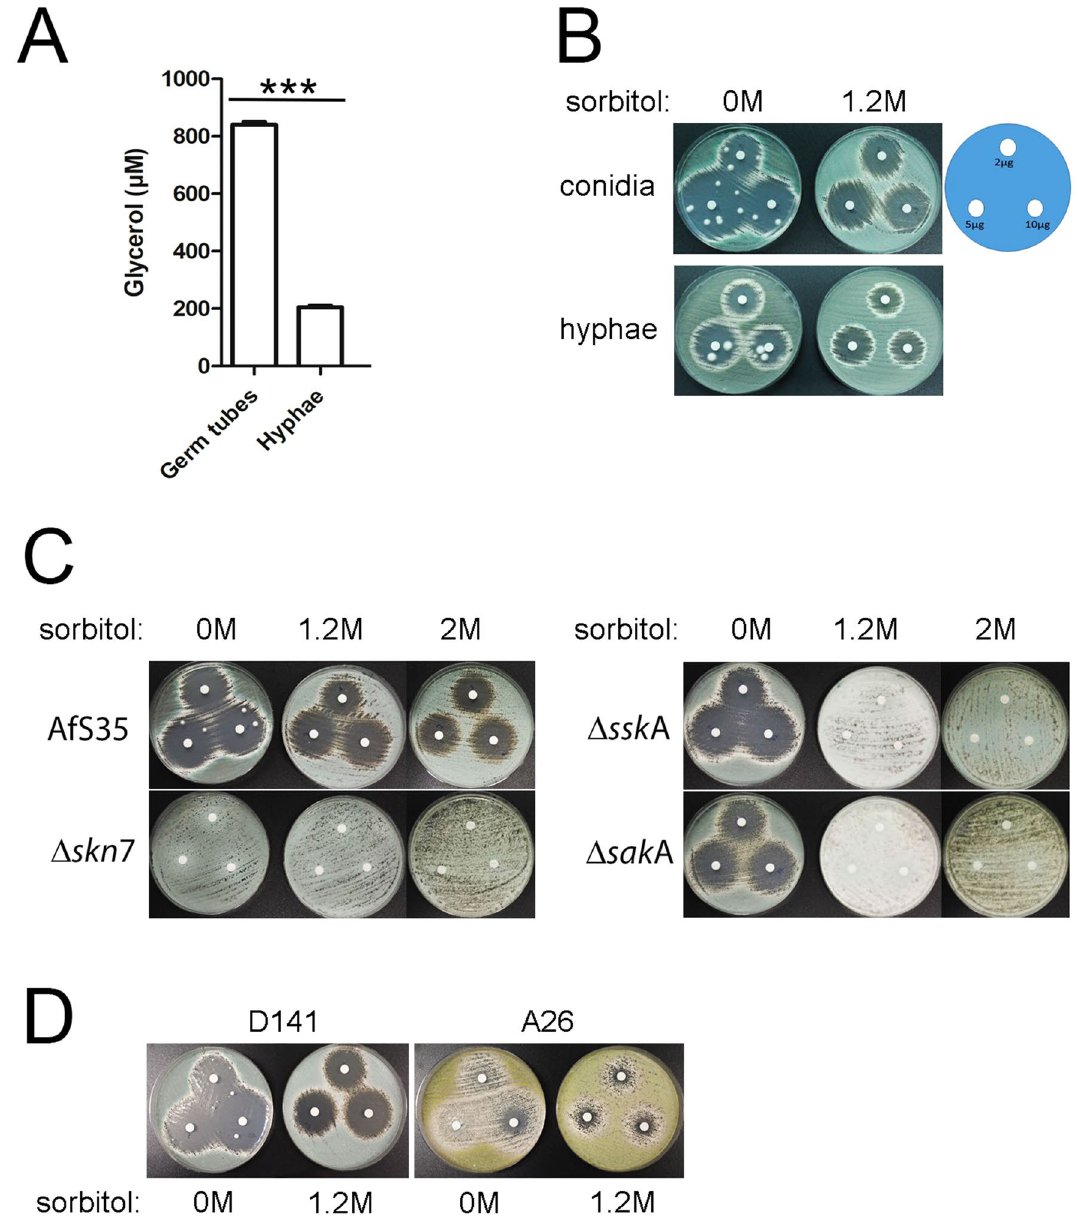
Figure 8. Impact of osmoprotection on the antifungal activity of fludioxonil. (Panel A) comparison of the glycerol concentrations of extracts obtained from germ tubes and hyphae of A. fumigatus . The data were analyzed using a Student’s t-test, ***: p < 0.001. ( B ) Fludioxonil loaded paper disks were placed on AMM plates with resting conidia (conidia) or pre-grown hyphae (hyphae) that were in part supplemented with 1.2 M sorbitol. The disks contained 2, 5 and 10 µg of fludioxonil as indicated. Note that resistant colonies in the inhibition zones occurred only on plates without sorbitol. (Panel C ) shows a similar osmoprotection experiment as in (panel B ), but this time we compared the wild type and different HOG mutants. In this experiment, all plates were inoculated with resting conidia and contained either 0 M, 1.2 M or 2 M sorbitol as indicated. The paper disks contained 2, 5 and 10 µg of fludioxonil and were placed as indicated in (panel B ). (Panel D ) shows a comparison of A. fumigatus strain D141 and the A. nidulans strain A26. Plates were inoculated with resting conidia. The different sorbitol concentrations are indicated. The paper disks contained 2, 5 and 10 µg of fludioxonil and were placed as indicated in (panel B